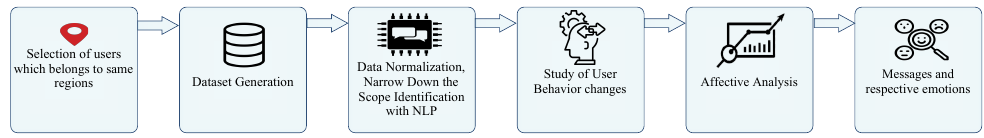
Figure 8. General procedure for functioning of